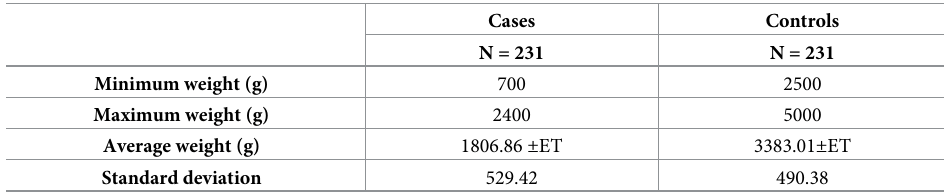
Table 1. Characteristics of the birth weight distribution of the two